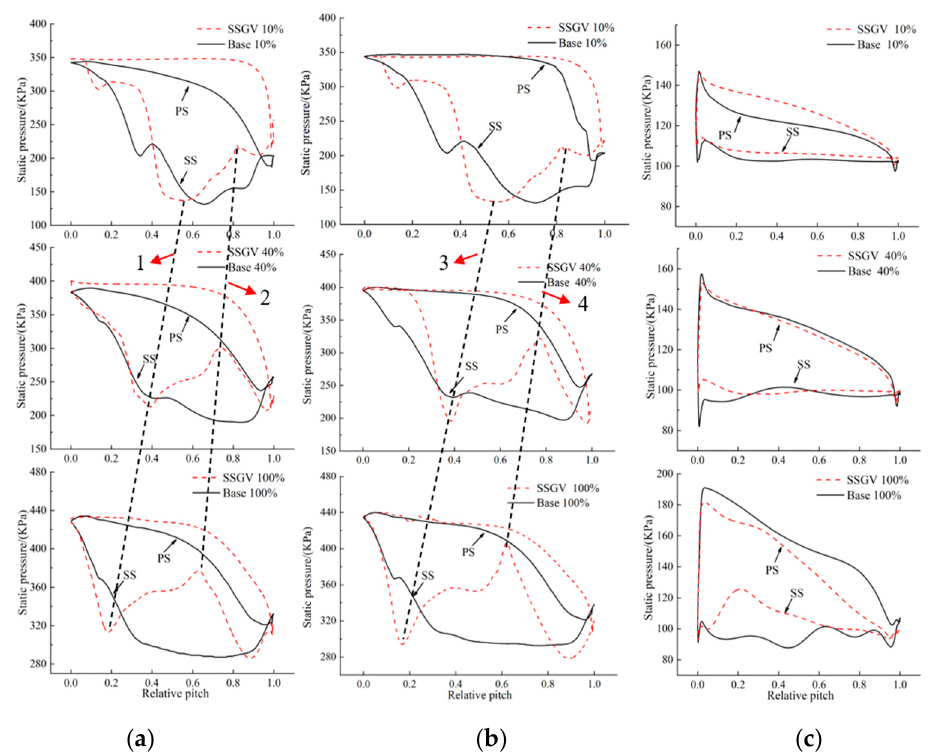
Figure 8. Pressure distribution of the two models at a 90% and 50% blade height: ( a ) pressure of the guide vane at a 90% height; ( b ) pressure of the guide vane at a 50% height; ( c ) pressure of the rotor blade at a 90% height.